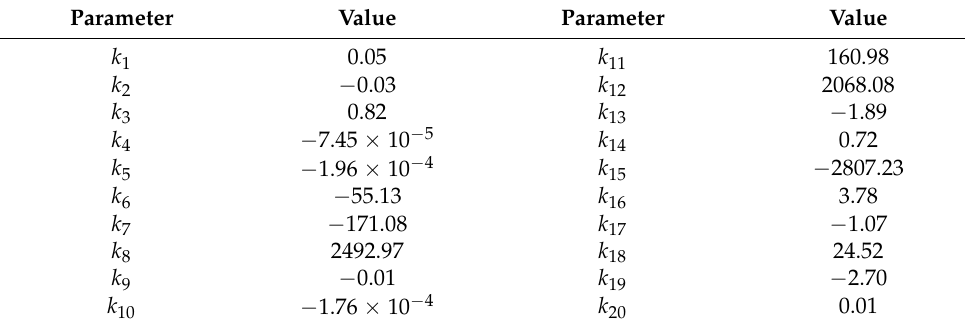
Table 1. Statistics of error fitting